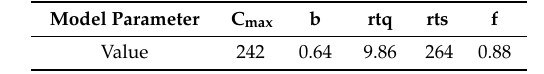
Table 8. Estimated PDM model parameters for catchment C4 using conventional regression.